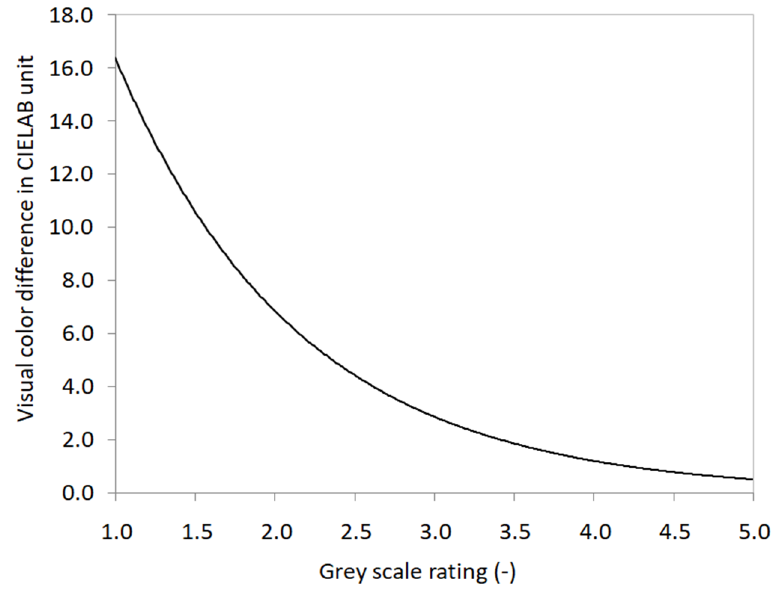
Figure 5. Visual color difference in CIELAB unit as a function of gray-scale rating.